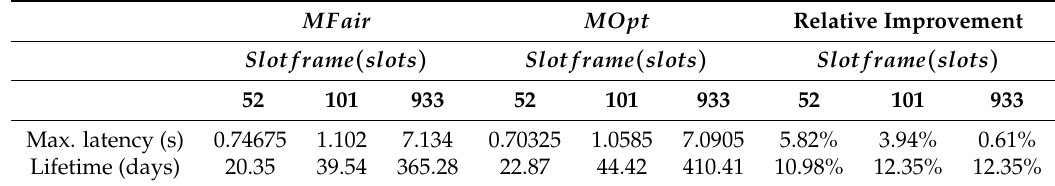
Table 8. The trade-off of end-to-end latency versus network lifetime for MFair and MOpt . MFair MOpt Relative Improvement Slot frame ( slots ) Slot frame ( slots ) Slot frame ( slots ) 52 101 933 52 101